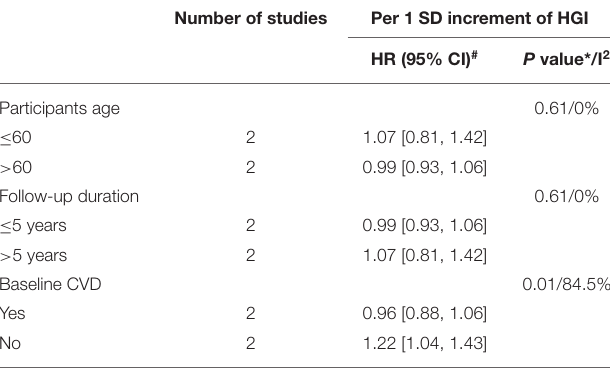
TABLE 2 | Subgroup analyses of the association between HGI and risk of composite